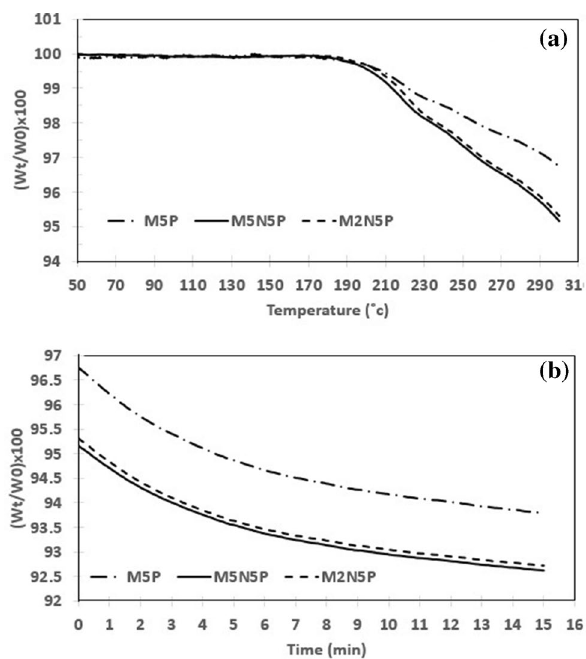
Fig. 8 Comparing the results of TGA analysis of M2N5P and M5N5P samples with M5P a at 300 ◦ C 300 (see Table 1 for